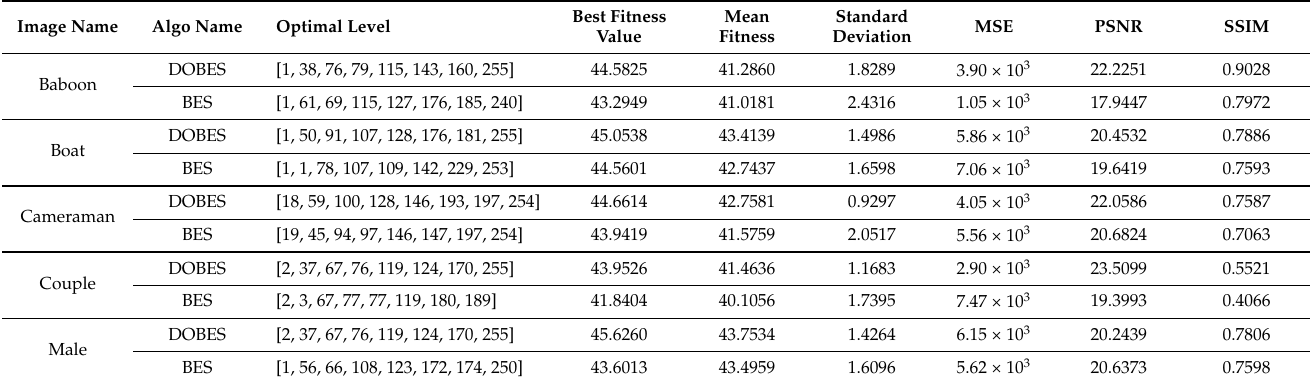
Table 1. Evaluation metrics of the proposed DOBES and original BES algorithm for benchmark